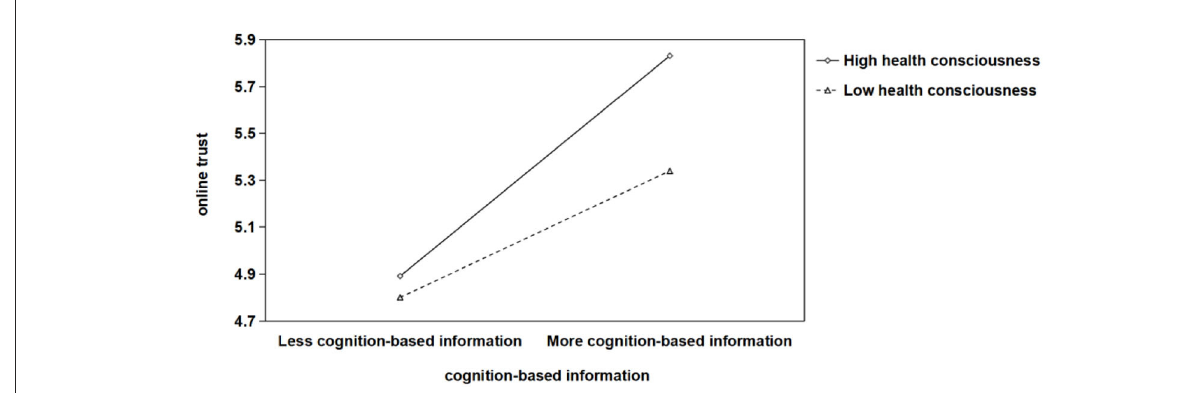
FIGURE2 Interaction chart for different levels ( ± 1 standard deviation) of health consciousness in the mediating model of “cognition-based information → online trust → patients’ willingness to conduct online health consultation”.